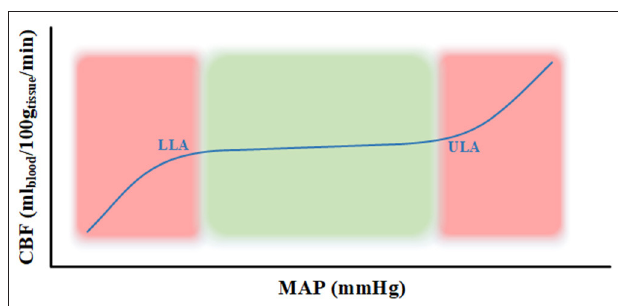
FIGURE 1 | Lassen autoregulatory curve. The curve represents the Lassen autoregulatory curve (3) where the lower limit of autoregulation (LLA) and upper limit of autoregulation (ULA) are appropriately labeled. The part of the curve in the green area represents intact autoregulation and the part in the red area signifies impaired autoregulation. CBF, cerebral blood flow; g, grams; LLA, lower limit of autoregulation; MAP, mean arterial pressure; min, minute; ml, milliliters; mmHg, millimeter of mercury; ULA, upper limit of autoregulation.